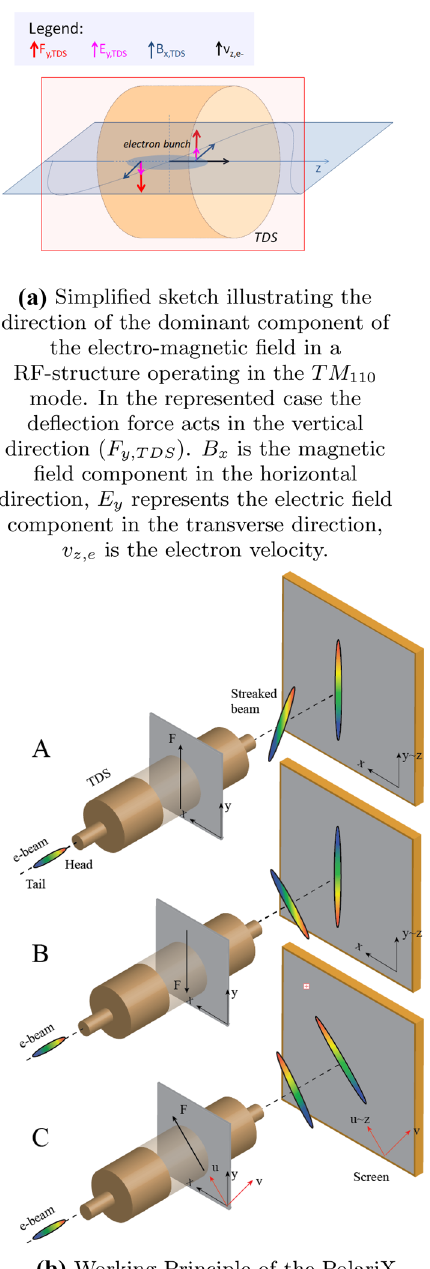
Figure 1. The PolariX